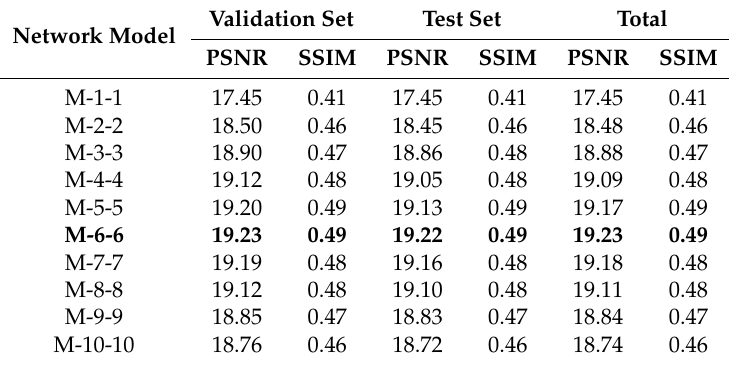
Table 3. Performance results when varying the number of blocks ( N e and N d ) in symmetric structured networks. Bold-faced numbers indicate the top-ranked network model and its